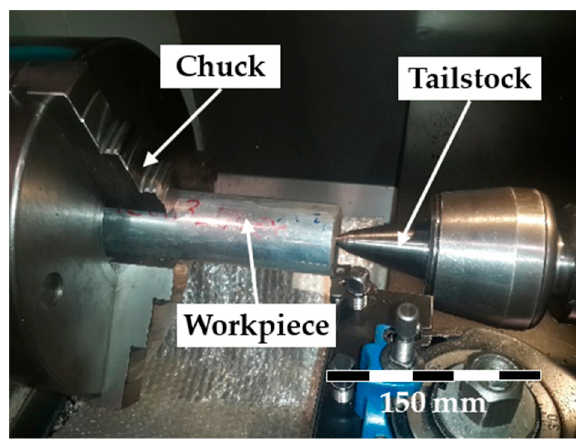
Figure 11. Turning trials: Set up for an aluminum workpiece.